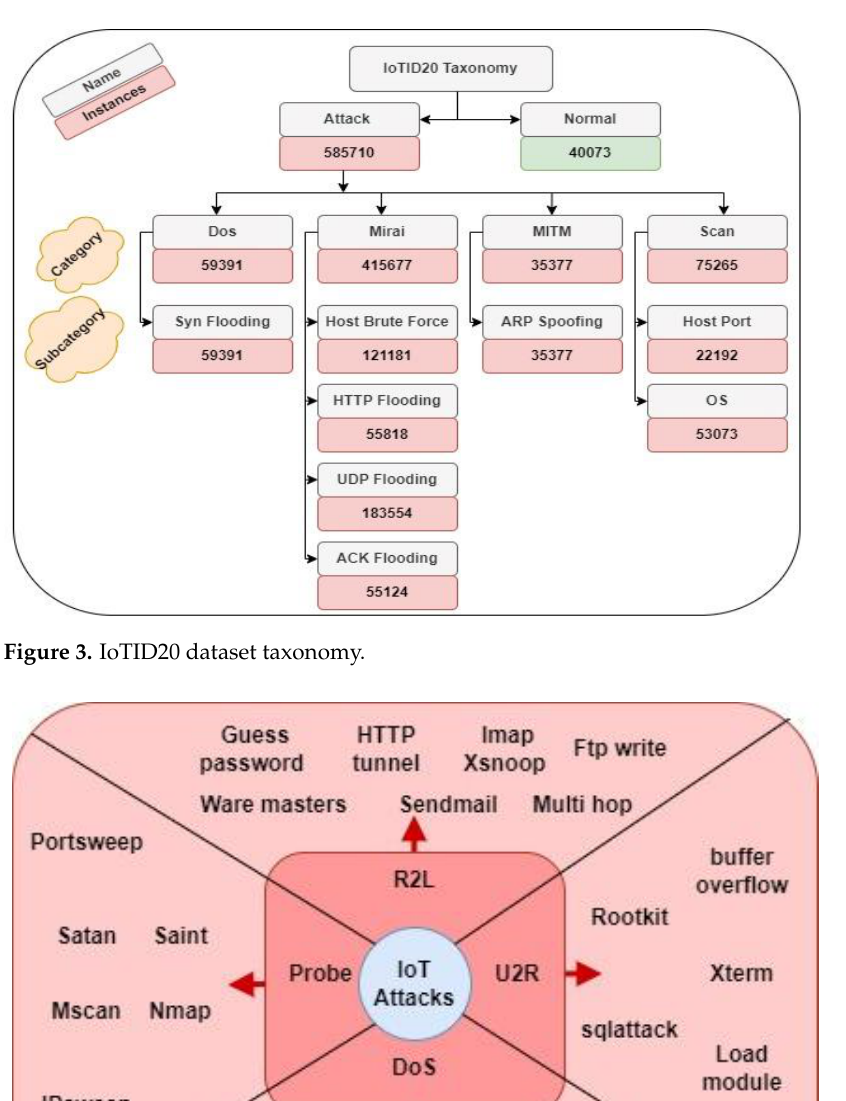
Figure 2. The IoTID20 dataset testbed environment.